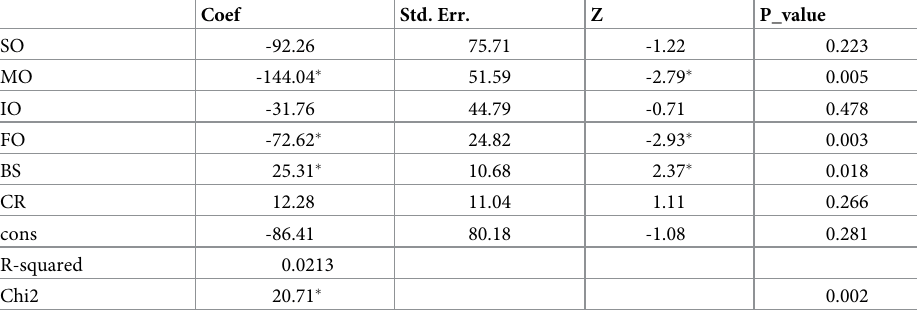
Dependent variable: EPS, � indicates statistical significance at